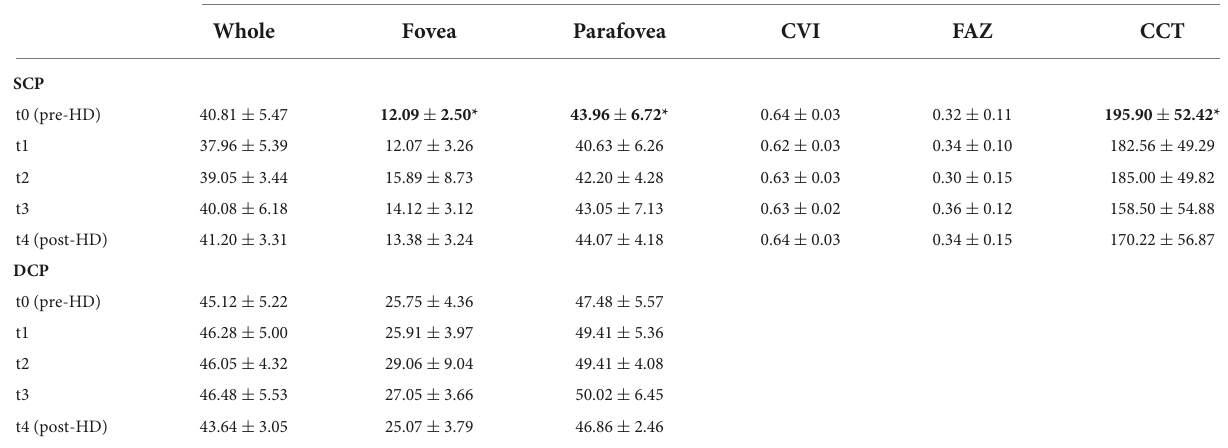
TABLE 3 Dialysis changes in OCT-A metrics in the hypotension-group. Variable